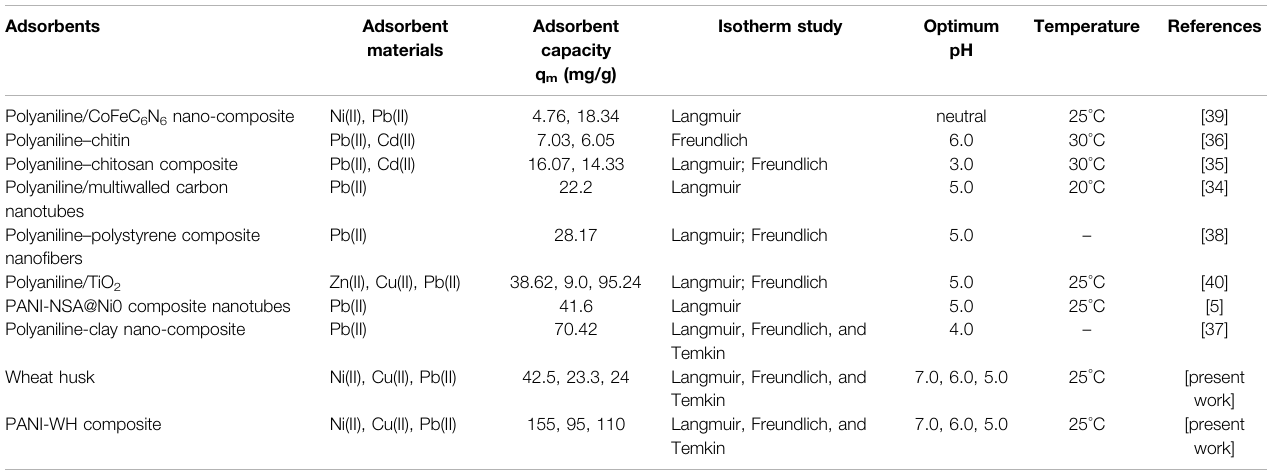
TABLE 5 | Comparison of different adsorbents with a prepared